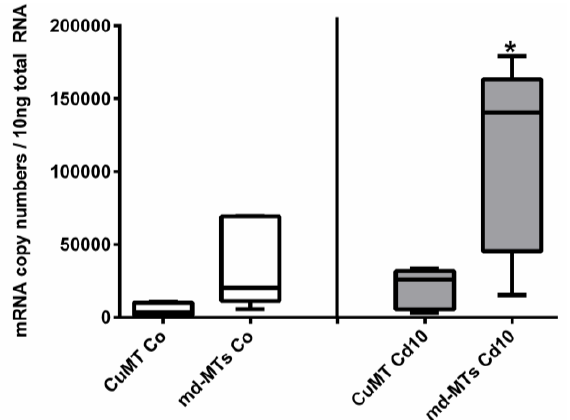
Figure 7. Comparison of mRNA expression levels of CuMT versus joined md-MT genes ( 9md-MT + 10md-MT ) in A. biplicata . Whisker box plots from the lowest to the highest values, showing transcription levels for controls (white whisker box plots, left-hand side) and snails exposed to 355 µg/g d.w. (Cd10) (grey whisker box plots, right-hand side; n = 5 each). The box of each treatment group extends from the 25th to the 75th percentile, with the square line showing the median. Asterisks ( * ) indicate significance ( p < 0.05) upon comparison between CuMT transcription versus md-MT transcription in exposed snails (Cd10).